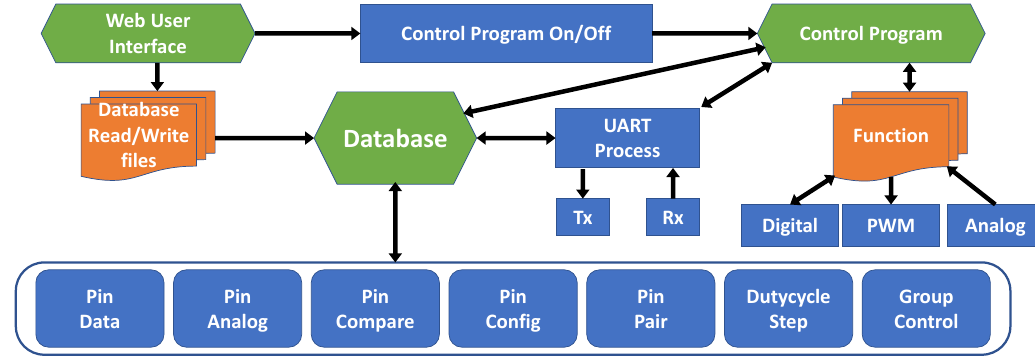
Figure 2. SoEasy detailed architecture.